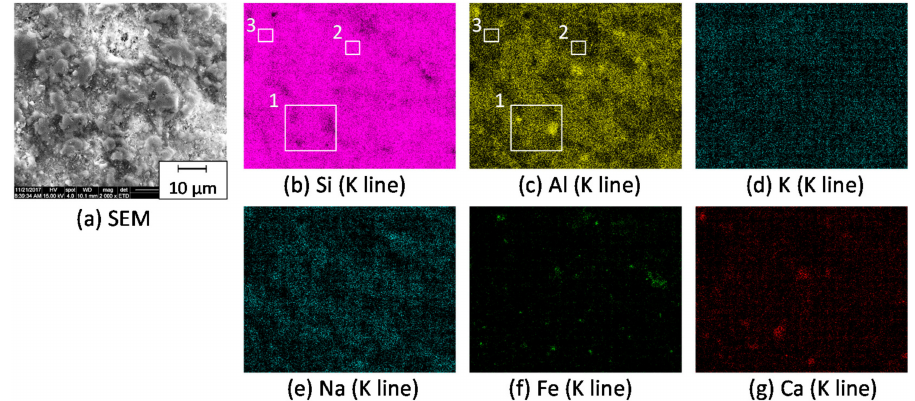
Figure 4. ( a ) Microstructure and ( b – g ) elementary distributions of the composite with 35.3 vol % zeolite–14.2 vol % porosity, hot-pressed at 950 ◦ C and annealed at 600 ◦